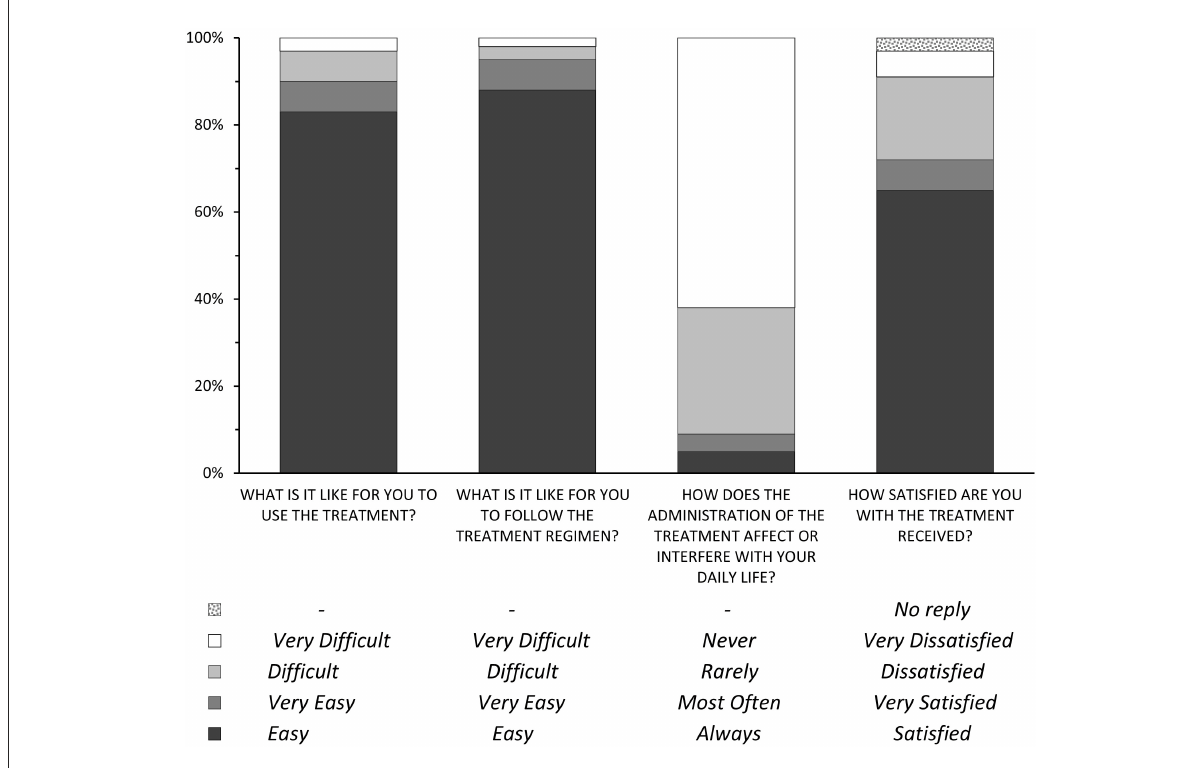
FIGURE2 Results of the satisfaction survey.